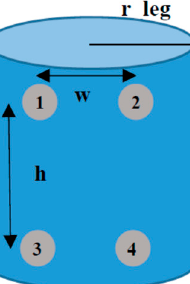
Figure 2. Leg geometry: A cylinder with r_leg radius and h height. r_leg = 4 cm. The h = 6 cm and w = 3.5 cm dimensions are the values between electrodes considered in the system, and for calibration.